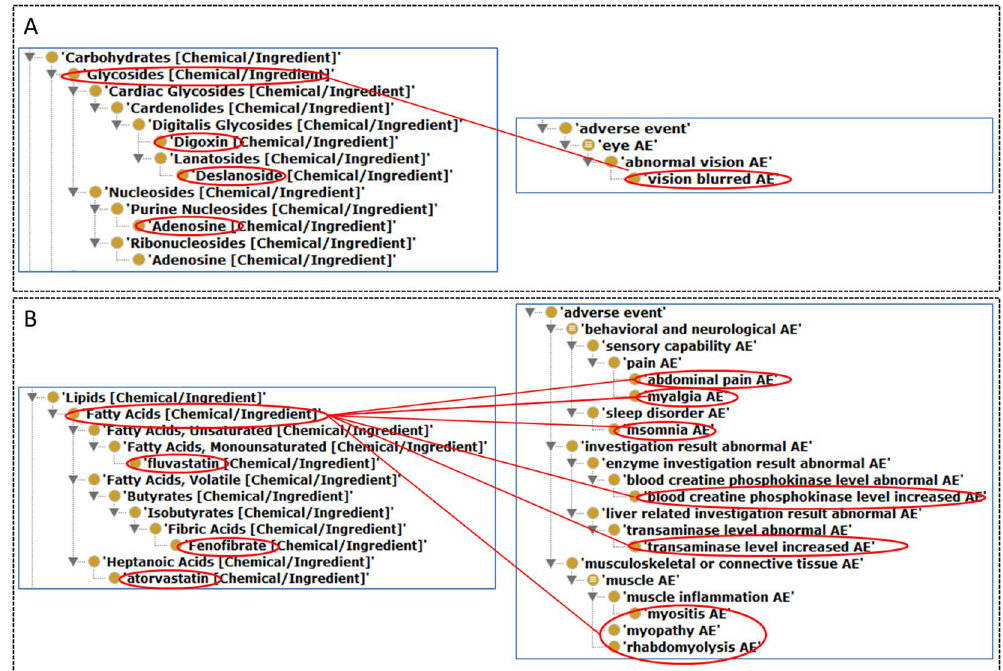
Figure 6. Statistically significant CVD class effects on different AEs based on 36 CVD ingredient classification. ( A ) Statistically significant class effect of glycosides on vision blurred AE, meaning that each of all three drugs under this class (i.e., adenosine, deslanoside, and digoxin) is statistically significantly associated with the AE. ( B ) Statistically significant class effects of fatty acids on 8 AEs. Only three drug ingredients (i.e., atorvastatin,